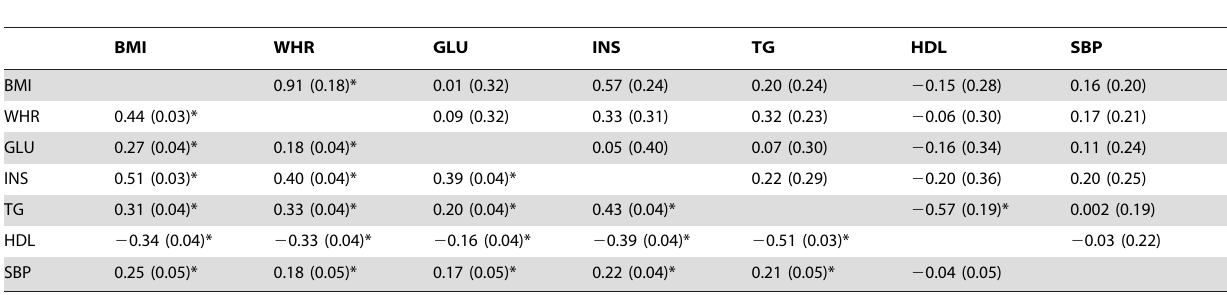
Table 3. Genetic and residual correlations between MetS traits in the ARIC population among unrelated individuals from the bivariate REML